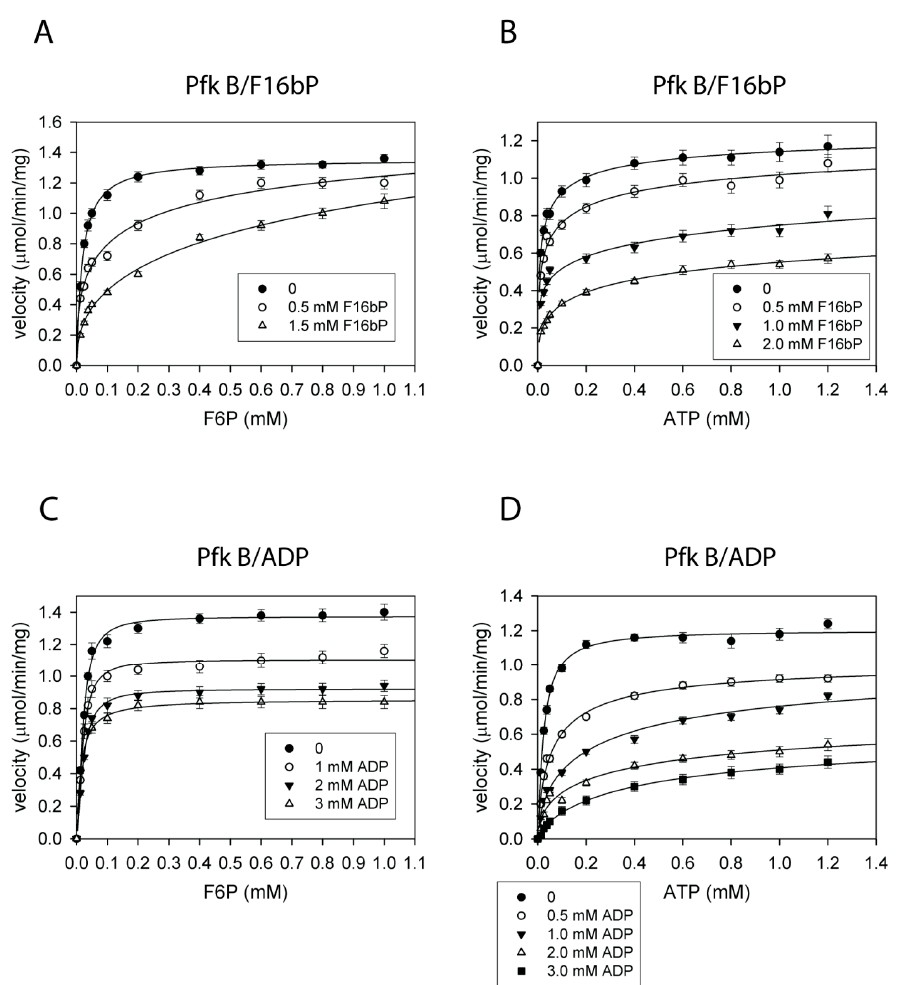
Figure 6. The feedback inhibition of Pfk B by F16bP ( A,B ) and ADP ( C,D ). Plots of the inhibitions with F6P varied and ATP fixed at 1 mM ( A , C ) and the inhibitions with ATP varied and F6P fixed at 1 mM ( B , D ). The data were fitted to Equation